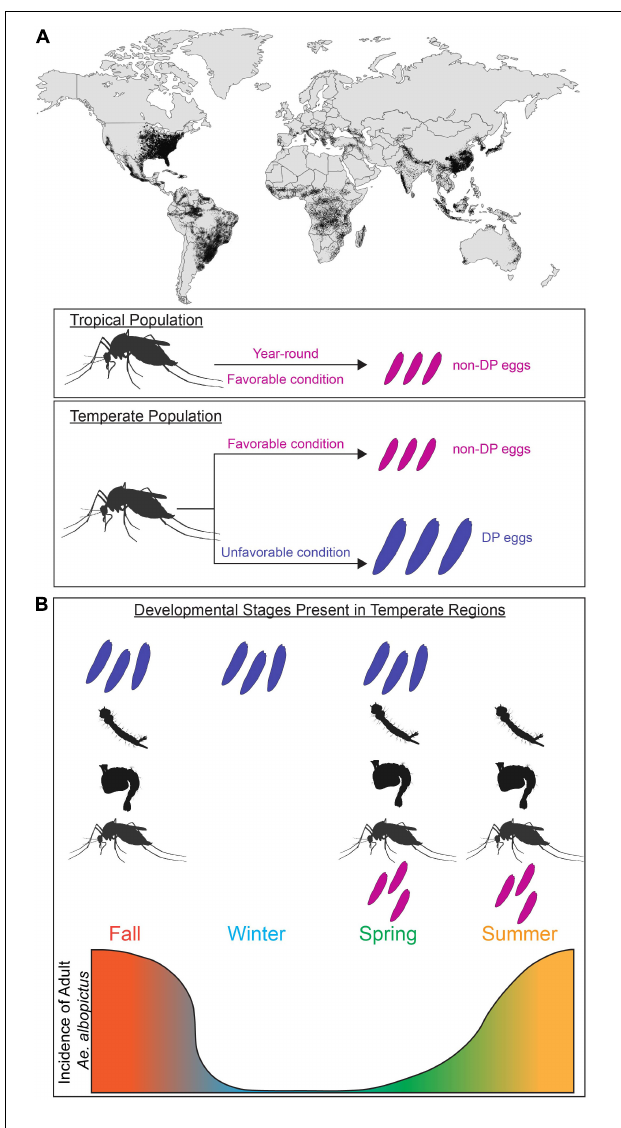
FIGURE 1 | Aedes albopictus global invasion and population expansion in temperate and tropical regions. (A) Global map of predicted distribution of Ae. albopictus population (adapted from Kraemer et al., 2015). Adult females found in tropical regions lay non-diapause eggs (magenta) majority of year-round. In temperate regions, adult females found in favorable conditions (magenta) lay non-diapause eggs. In unfavorable conditions, adult females alter their reproduction (blue) and lay diapause eggs (blue). (B) Incidence of Ae. albopictus at different life stages in temperate regions. Temperate population have unique subsets of developmental stages present (diapause and non-diapause egg, larva, pupa, adult) in each season. Incidence of adult Ae. albopictus in temperate region is depicted by the gradient graph.